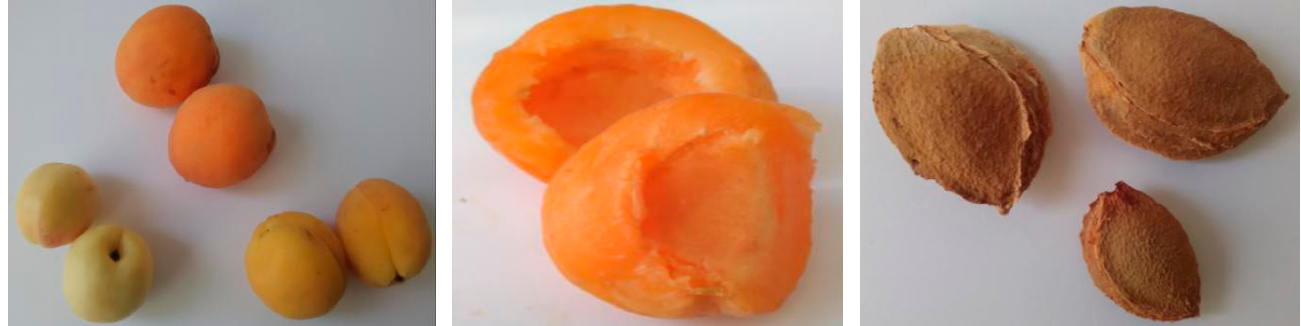
Figure 1. Apricot fruits and kernel shells.